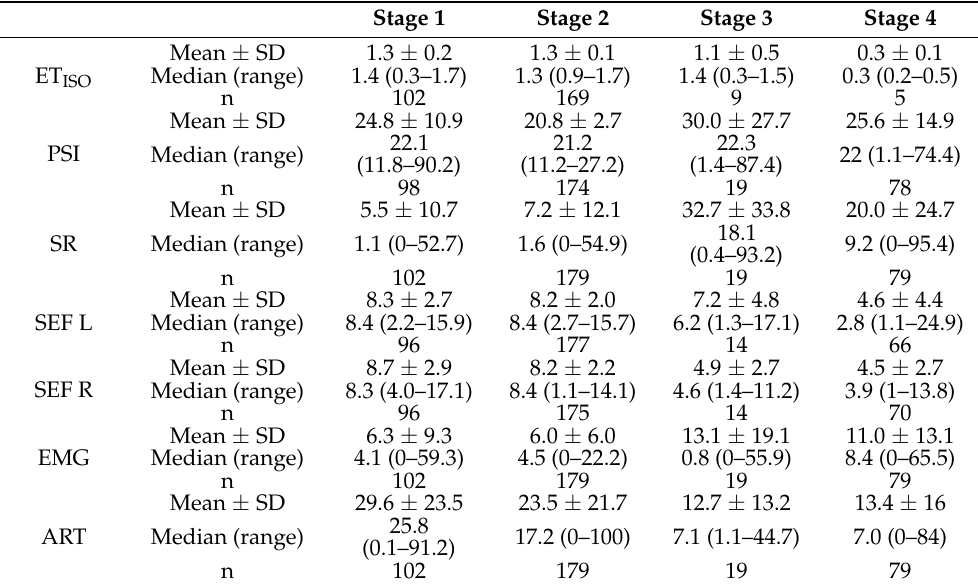
Table 3. Processed EEG parameters during the 4 stages of anesthesia in the isoflurane-anesthetized horse. Stage 1—transition from induction to isoflurane anesthesia, stage 2—surgery during isoflurane maintenance, stage 3—early recovery before xylazine administration, and stage 4—late recovery. The 5-min average EEG data are